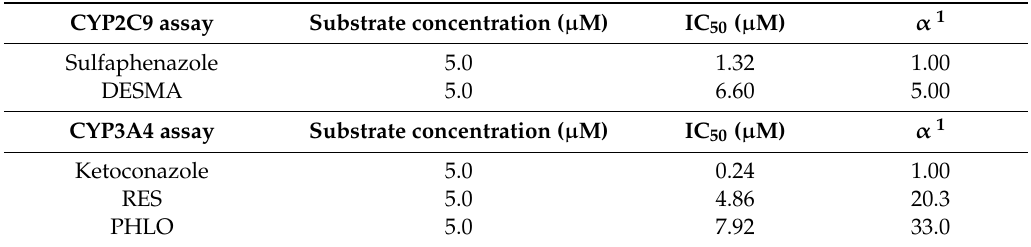
Table 2. Inhibitory e ff ects of DESMA, RES, PHLO, and the positive controls (sulfaphenazole and ketoconazole) on CYP2C9 or CYP3A4 enzymes. Data are derived from three independent experiments. CYP2C9 assay